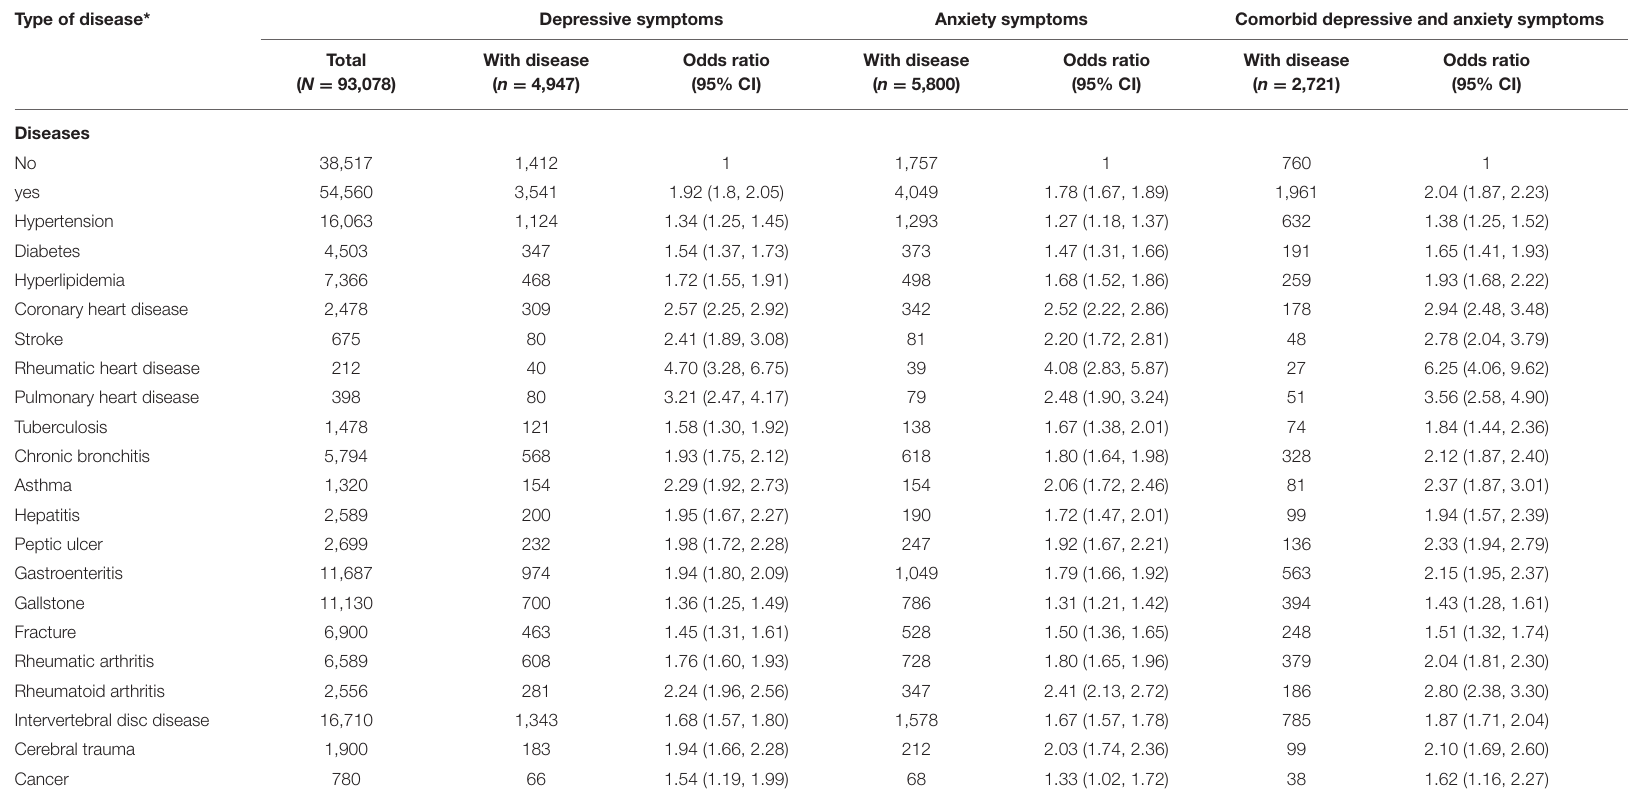
TABLE 3 | The adjusted ORs of chronic diseases and comorbid depressive and anxiety symptoms. Type of